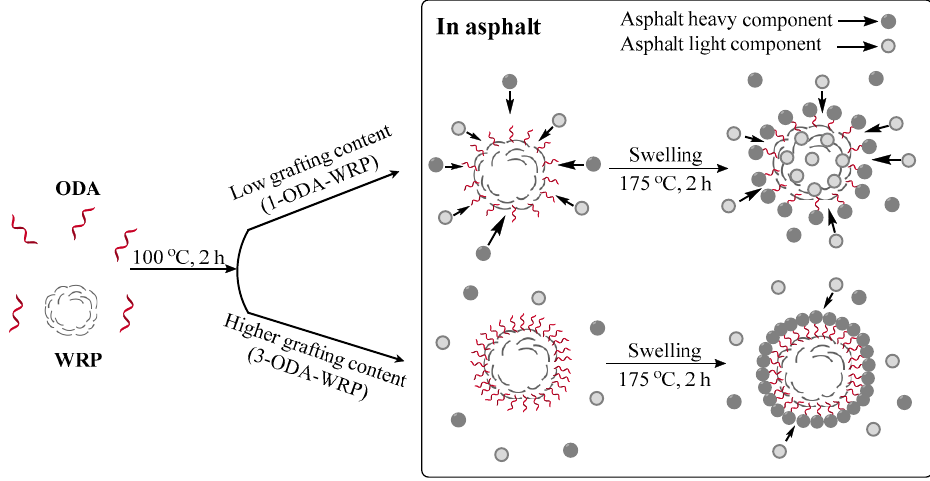
Figure 10. Formation mechanism of the ODA-WRP/SBS network structure.